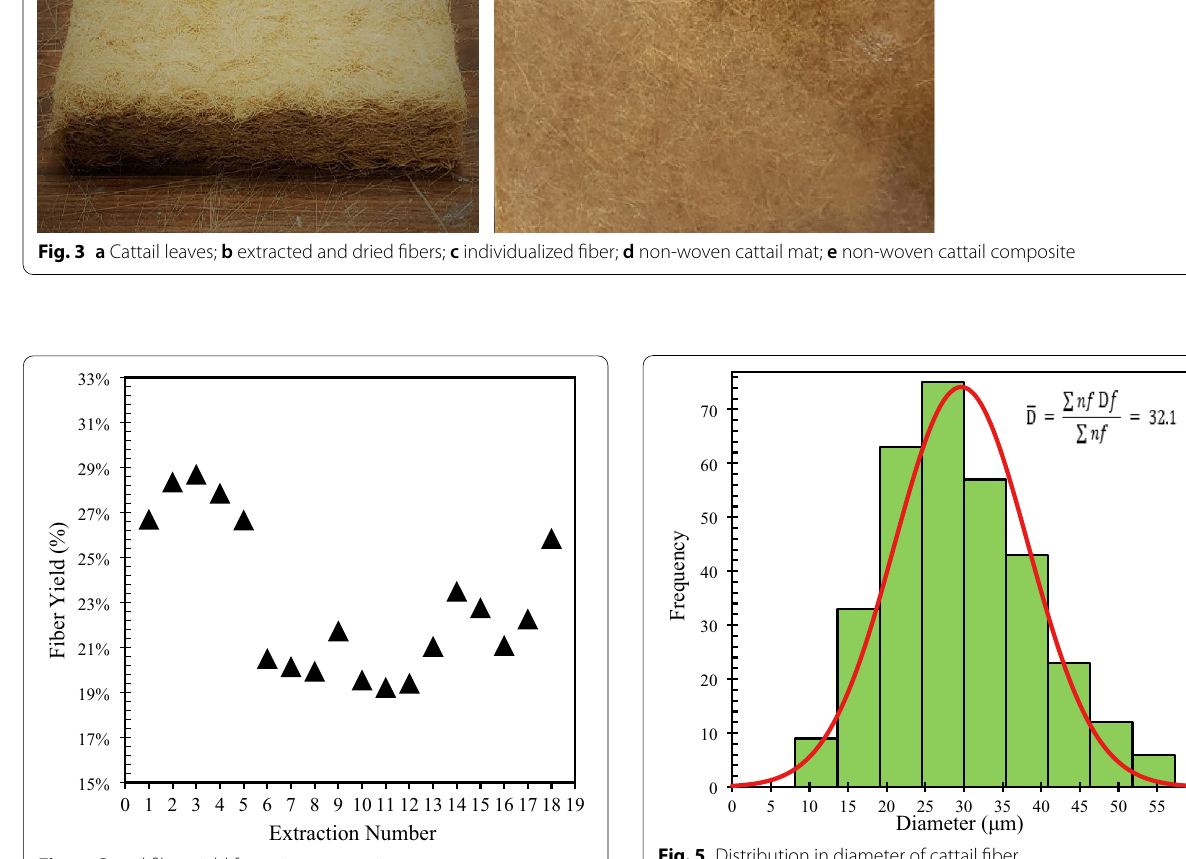
15% Fig. 4 Cattail fiber yield for various extraction runs